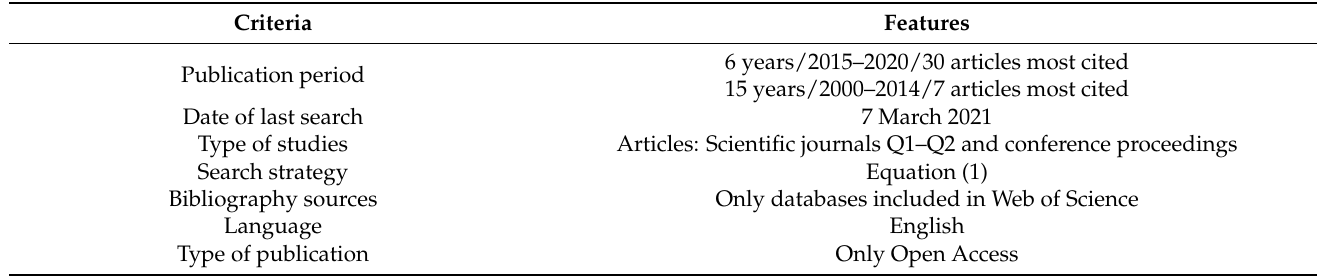
Table 3. Selection criteria and main characteristics of the structural lightweight materials